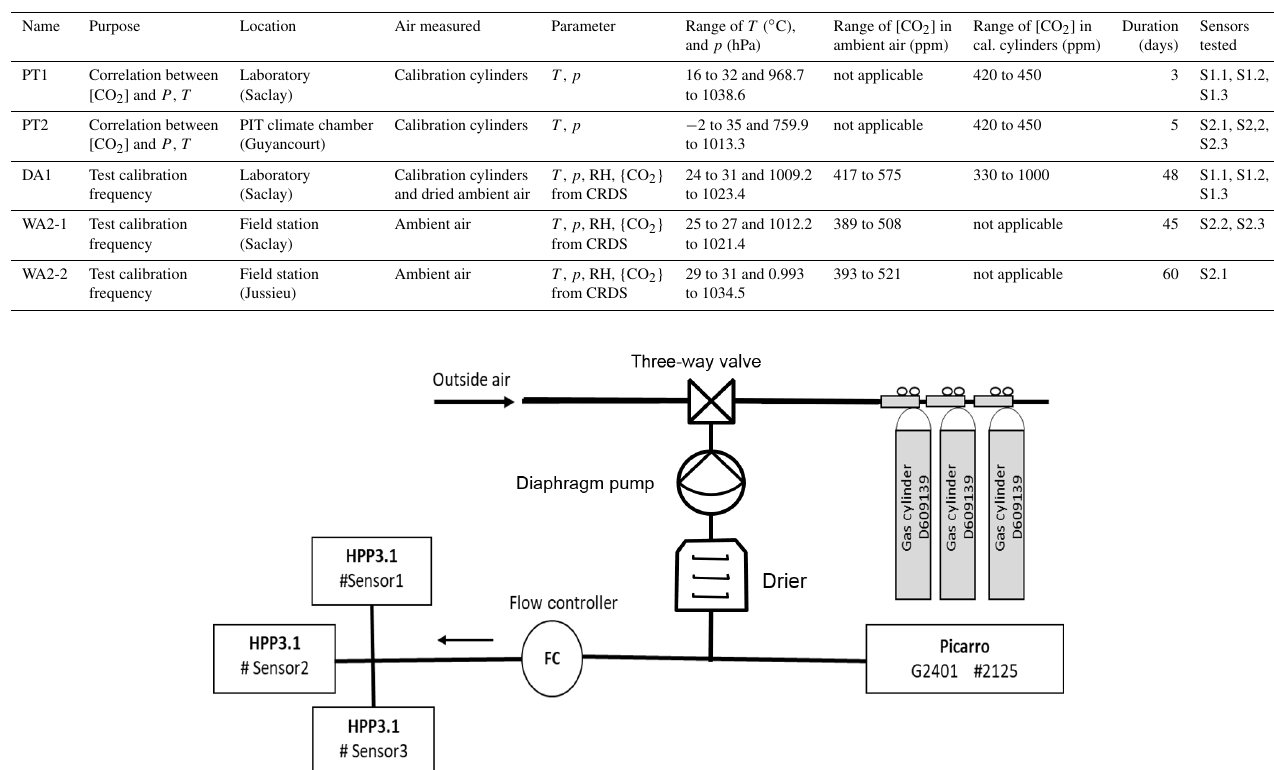
Table 1. Summary of all laboratory tests.